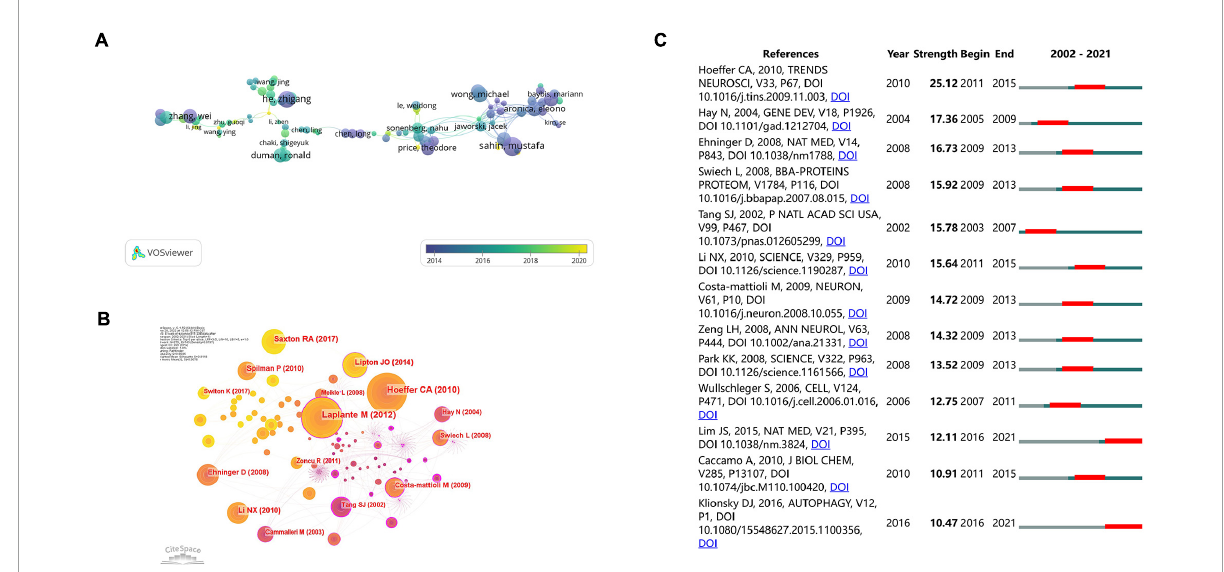
FIGURE5 Collaboration and citation networks among core authors and institutions. (A) Overlay visualization of co-authorship analysis of authors using VOSviewer. (B) Co-citation analysis of references using CiteSpace. (C) Top 13 references with the strongest citation bursts based on CiteSpace.